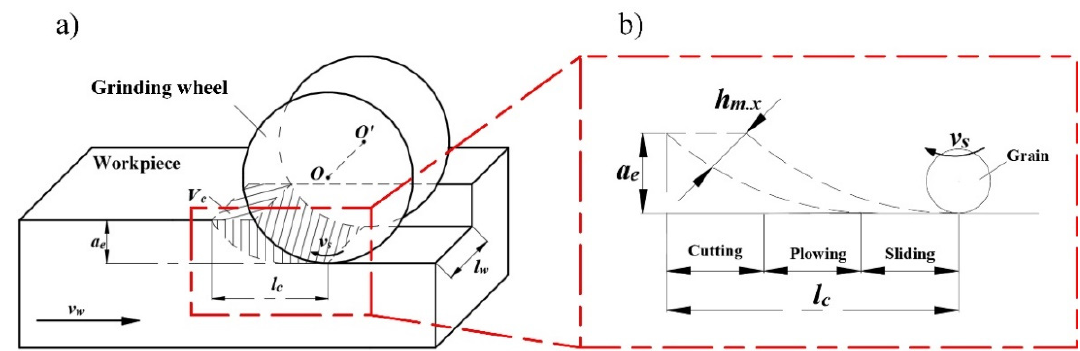
Figure 3. Schematic diagram of the grinding process. ( a ) Grinding motion diagram. ( b ) The division of the instantaneous grinding area.